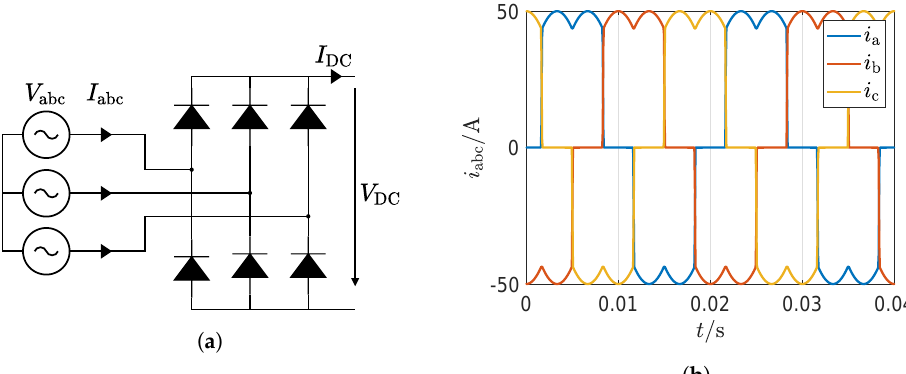
Figure 8. Origin of harmonic distortion current i harm . ( a ) Structure of a three-phase diode rectifier. ( b ) Input current of a three-phase diode